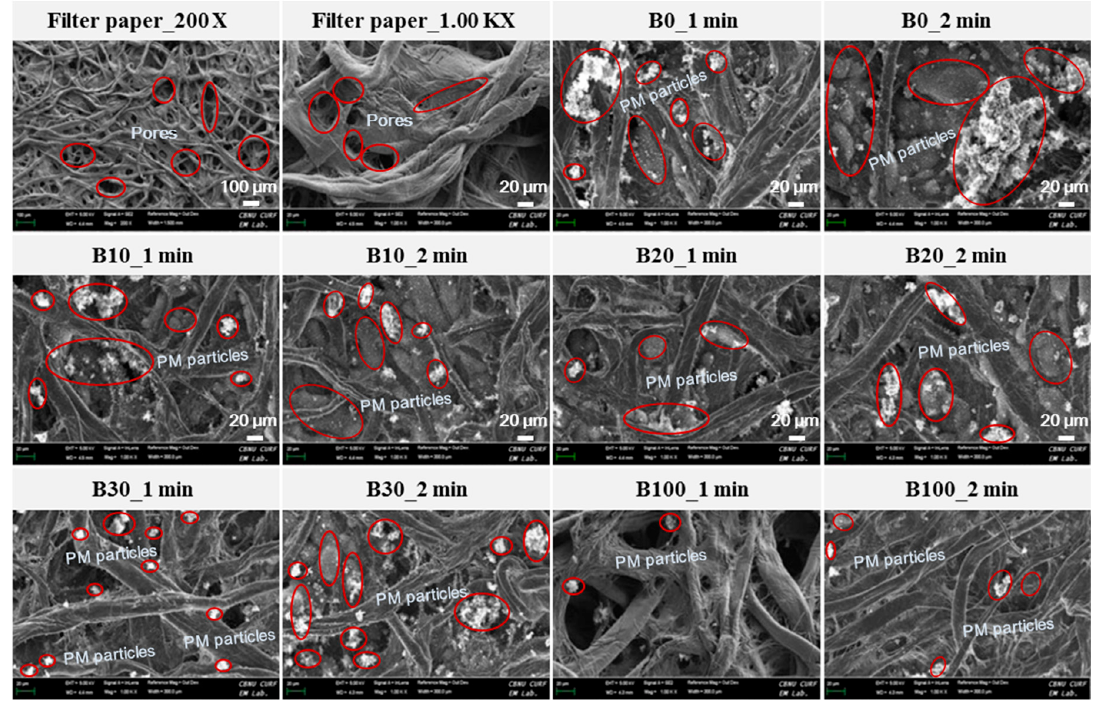
Figure 11. Comparisons of SEM images of paper filters covered with different amounts of particles.